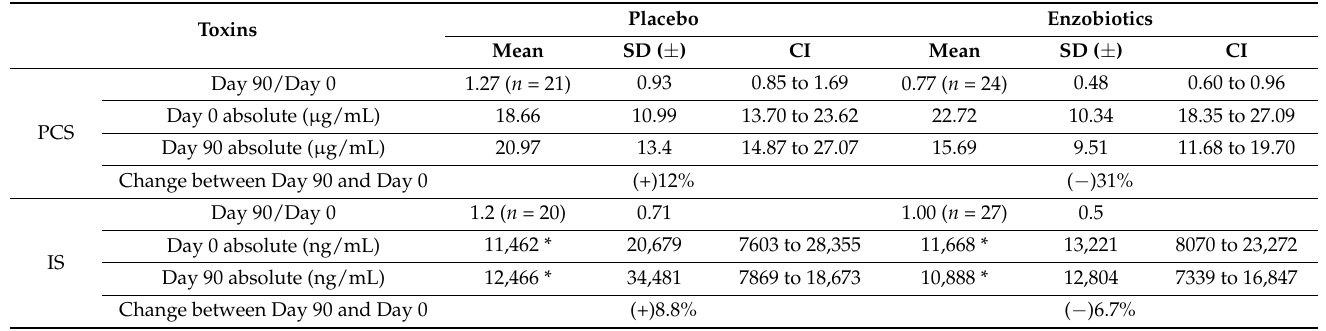
Table 4. Comparison of toxins between placebo and Enzobiotic